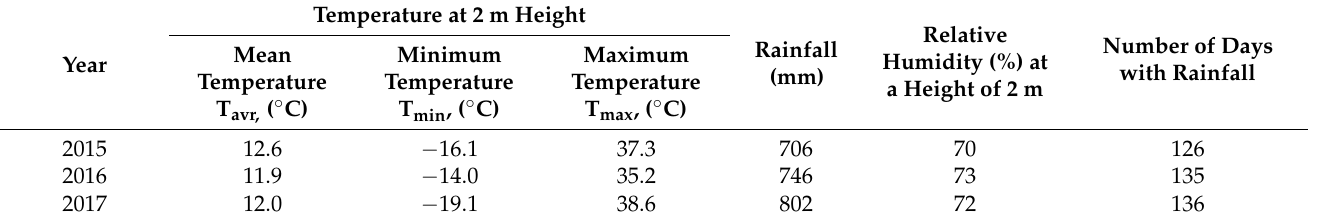
Table 1. Climatic data for Râmnicu Vâlcea area during study period (source of data: www.rp5.ru (accessed on 7 February 2022)).